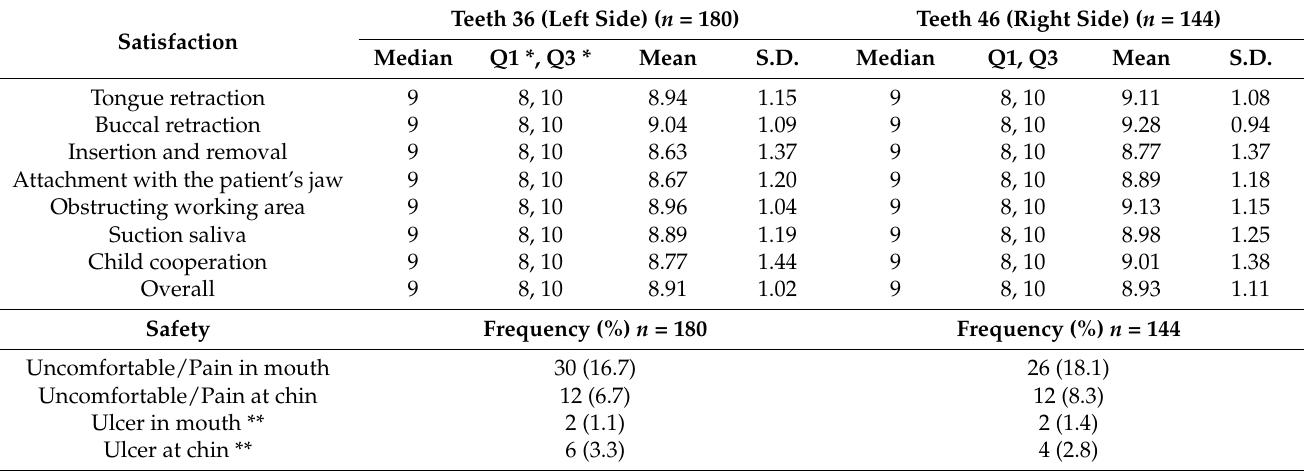
Table 3. Satisfaction and safety toward SS-suction innovation of 15 dental nurses (244 children and 324 teeth).